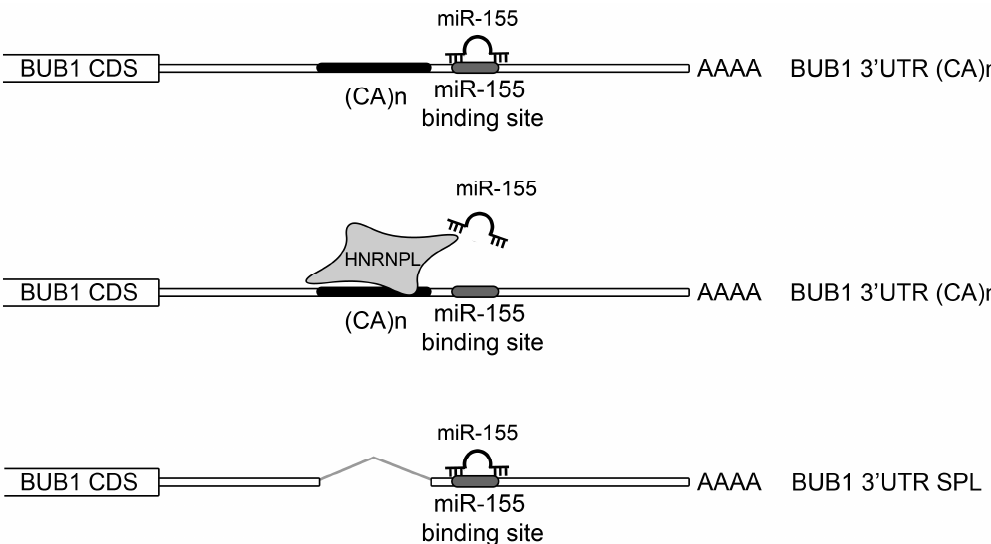
Figure 7. Graphical representation of the proposed model of miR-155 /HNRNPL/BUB1 axis . The targeting of BUB1 by miR-155 could be regulated by the binding of HNRNPL to the CA repeats in the BUB1 3 ′ UTR, hindering the availability of the miR-155 binding site. In the shorter form of the 3 ′ UTR of BUB1 , HNRNPL cannot bound the 3 ′ UTR, permitting the post-transcriptional regulation of BUB1 by the miR-155 .